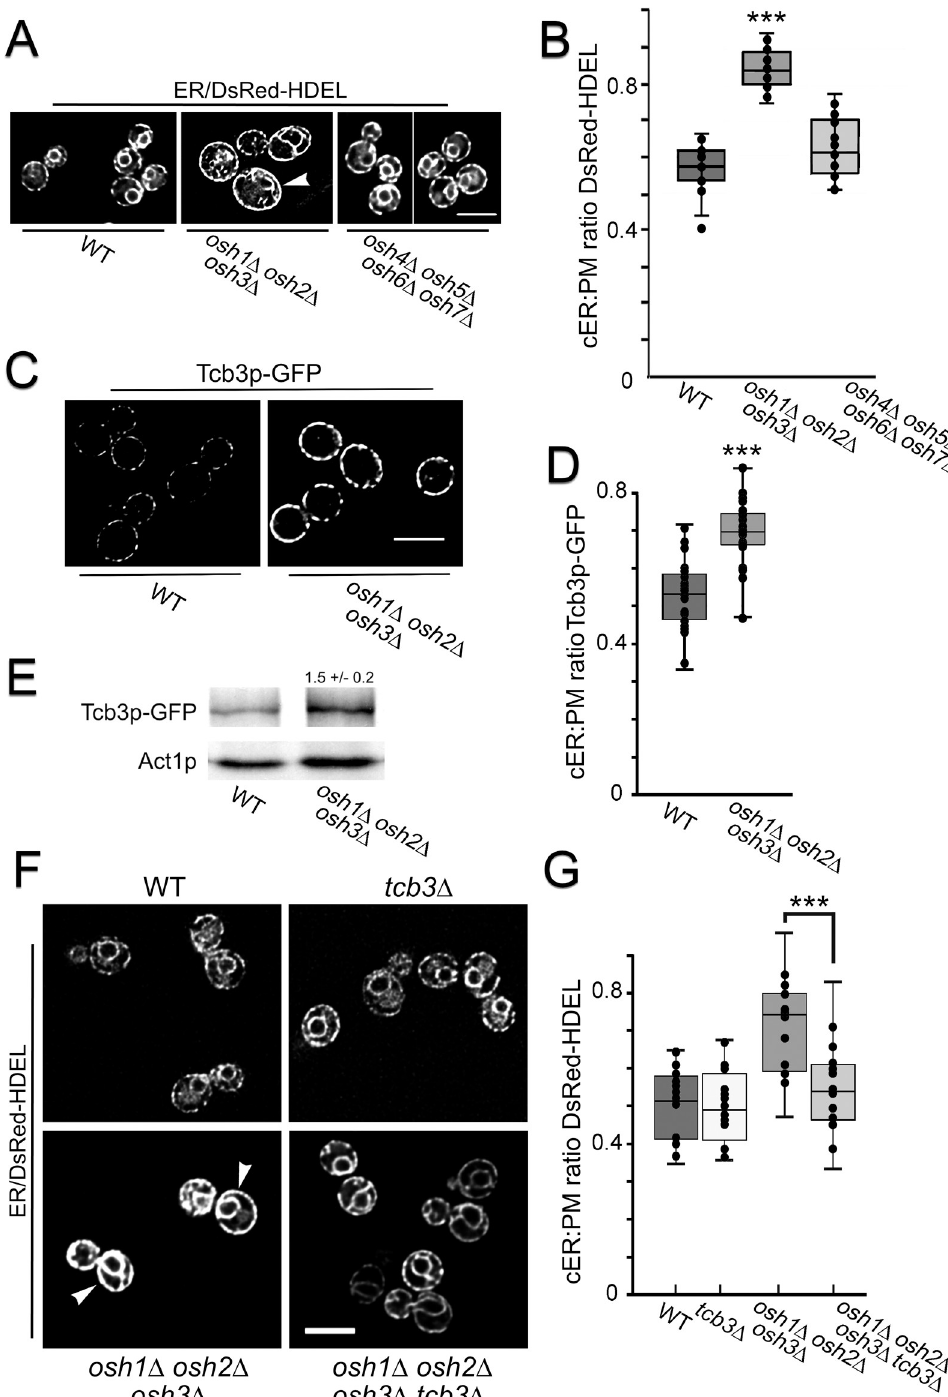
Fig 3. Elimination of FFAT-containing (long) Osh proteins increase Tcb3p-dependent cortical ER-PM association. (A) Representative fluorescent microscopy images of WT (SEY6210), osh1 Δ osh2 Δ osh3 Δ (lacking “long” OSHs ; JRY6253) and osh4 Δ osh5 Δ osh6 Δ osh7 Δ (lacking “short” OSHs ; JRY6272) cells expressing DsRed-HDEL (pRS416-DsRed-HDEL) cultured at 30˚C. ( B) Quantified ratios for total cortical DsRed-HDEL fluorescence length per total PM length in WT, osh1 Δ osh2 Δ osh3 Δ , and osh4 Δ osh5 Δ osh6 Δ osh7 Δ cells (n = 20 cells per strain). ��� p = 1.9 x 10 − 16 compared to WT. ( C) Images of WT and osh1 Δ osh2 Δ osh3 Δ (CBY7274) expressing TCB3 -GFP cultured at 30˚C. ( D) Quantified ratios of total cortical Tcb3p-GFP fluorescence length to total PM length in WT and osh1 Δ osh2 Δ osh3 Δ